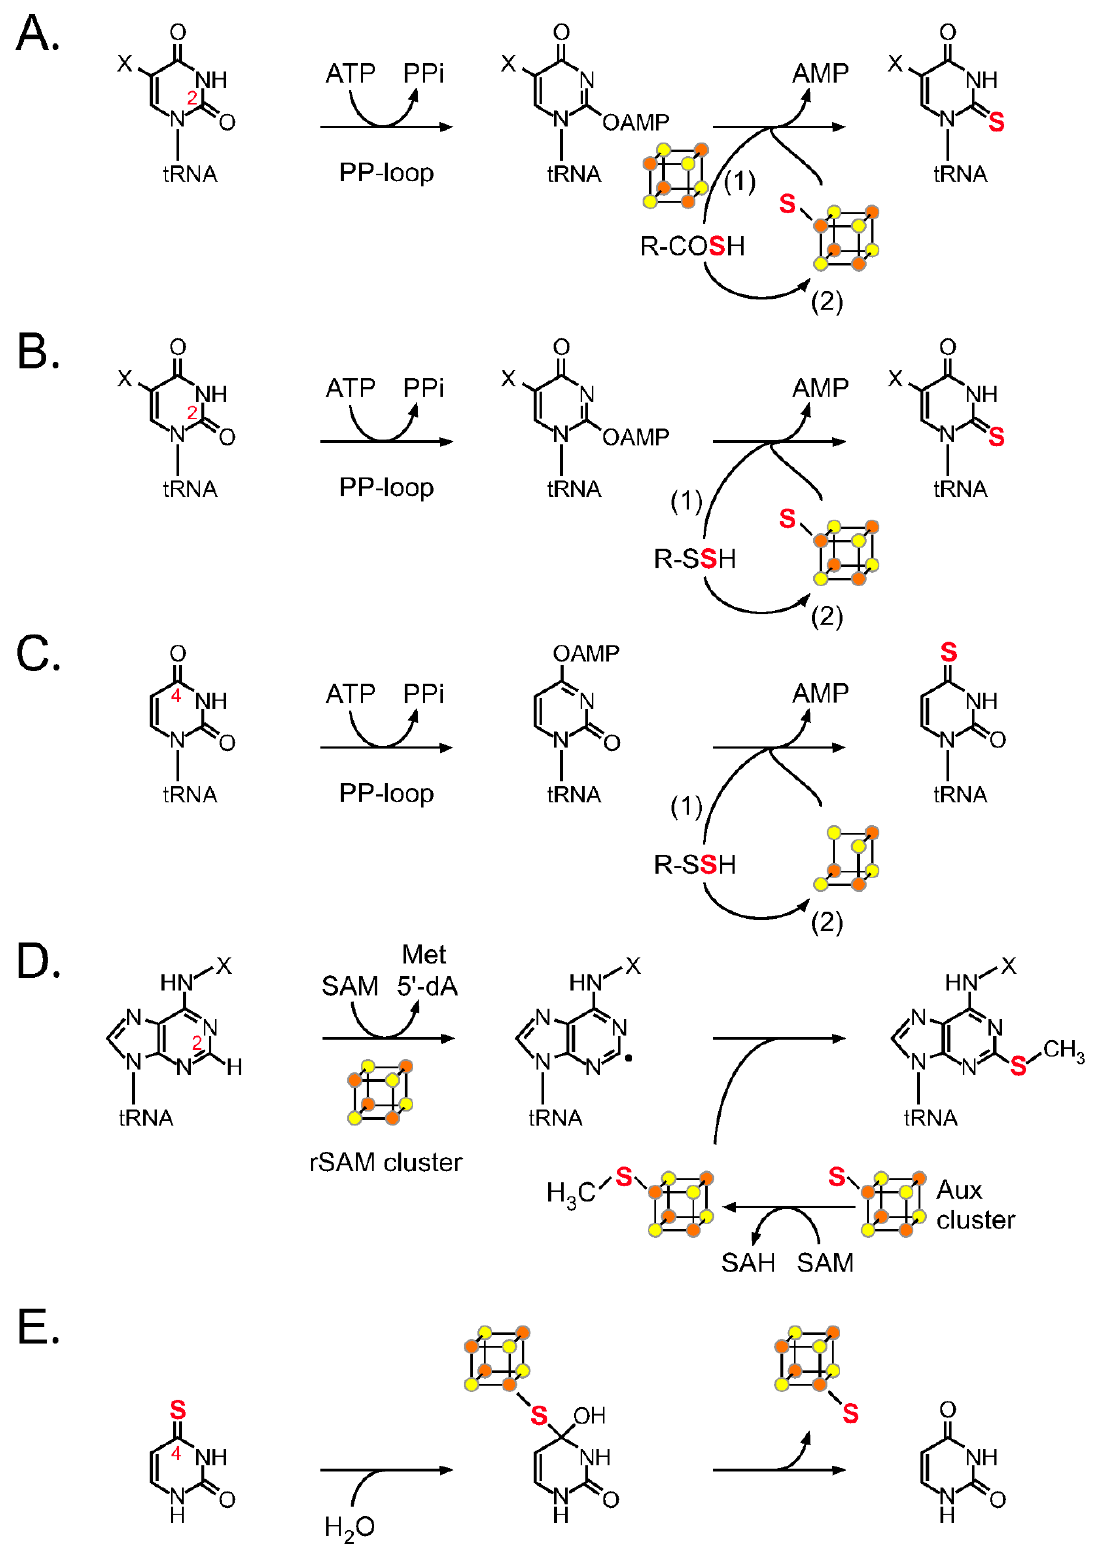
Figure 2. Reaction mechanisms of representative tRNA sulfurtransferases and a desulfidase: ( A ) Reaction mechanism of sulfurization of uridine C2 by TtuA/Ncs6. A protein-bound thiocarboxylate is introduced into the tRNA either (1) directly or (2) once sulfur is transferred to the iron–sulfur cluster. ( B ) Mechanism of sulfurization at uridine C2 by MnmA. The protein-bound persulfide acts as a sulfur donor. A protein-bound persulfide is introduced into the tRNA either (1) without the aid of the iron–sulfur cluster or (2) once sulfur is transferred to the iron–sulfur cluster. ( C ) Mechanism of sulfurization